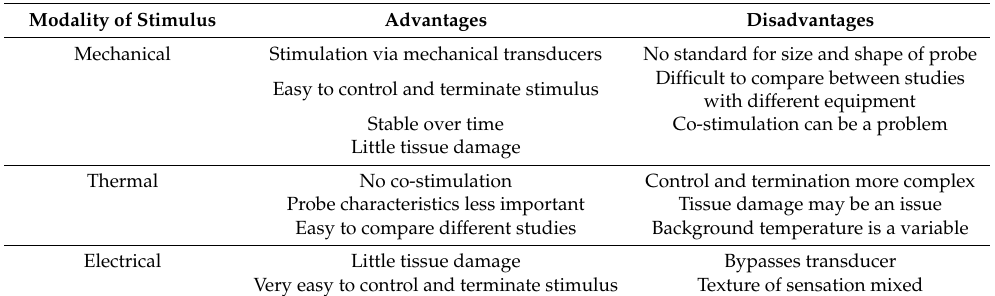
Table 1. Advantages and disadvantages of commonly used threshold testing